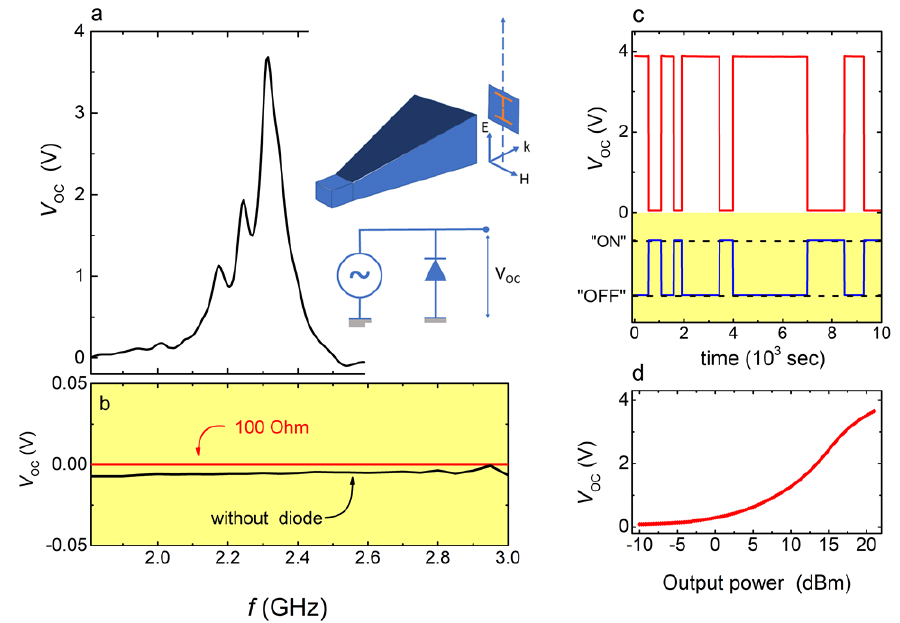
Figure 3. ( a ) Open circuit voltage V OC as a function of frequency f, for the FR-4 based MS (with diode, placed into the gap). The orientation of the MS, with respect to the horn is pictured in the included sketch (inset). The corresponding electronic circuit, is demonstrated, in the lower sketch. The AC voltage source equals the MS unit, which harvests energy; ( b ) V OC vs. f, for the same MS, without diode (black solid line) and with a resistor placed into the gap, instead of the diode (red solid line); ( c ) V OC vs. time (red solid line). The voltage value is zero when the horn power is OFF (blue solid line), while it is non-zero when horn power is ON. The stability of the voltage signal is obviously seen; ( d ) V OC as a function of the horn output